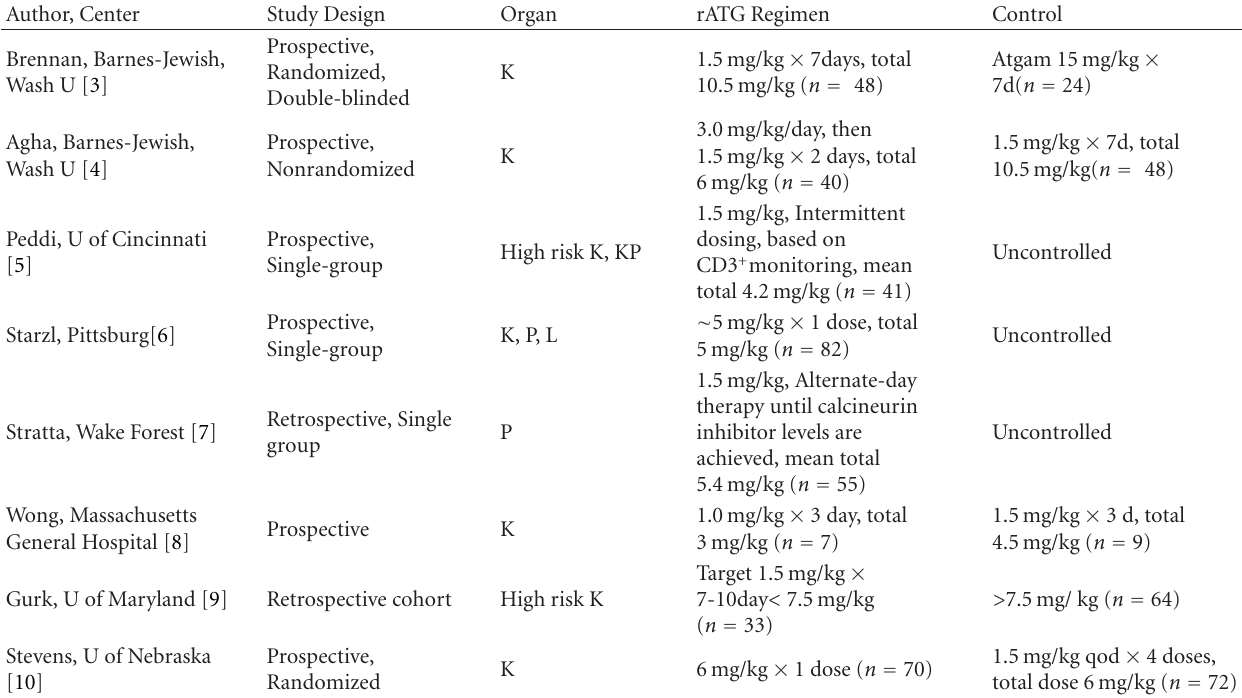
Table 3: Various rATG dosing